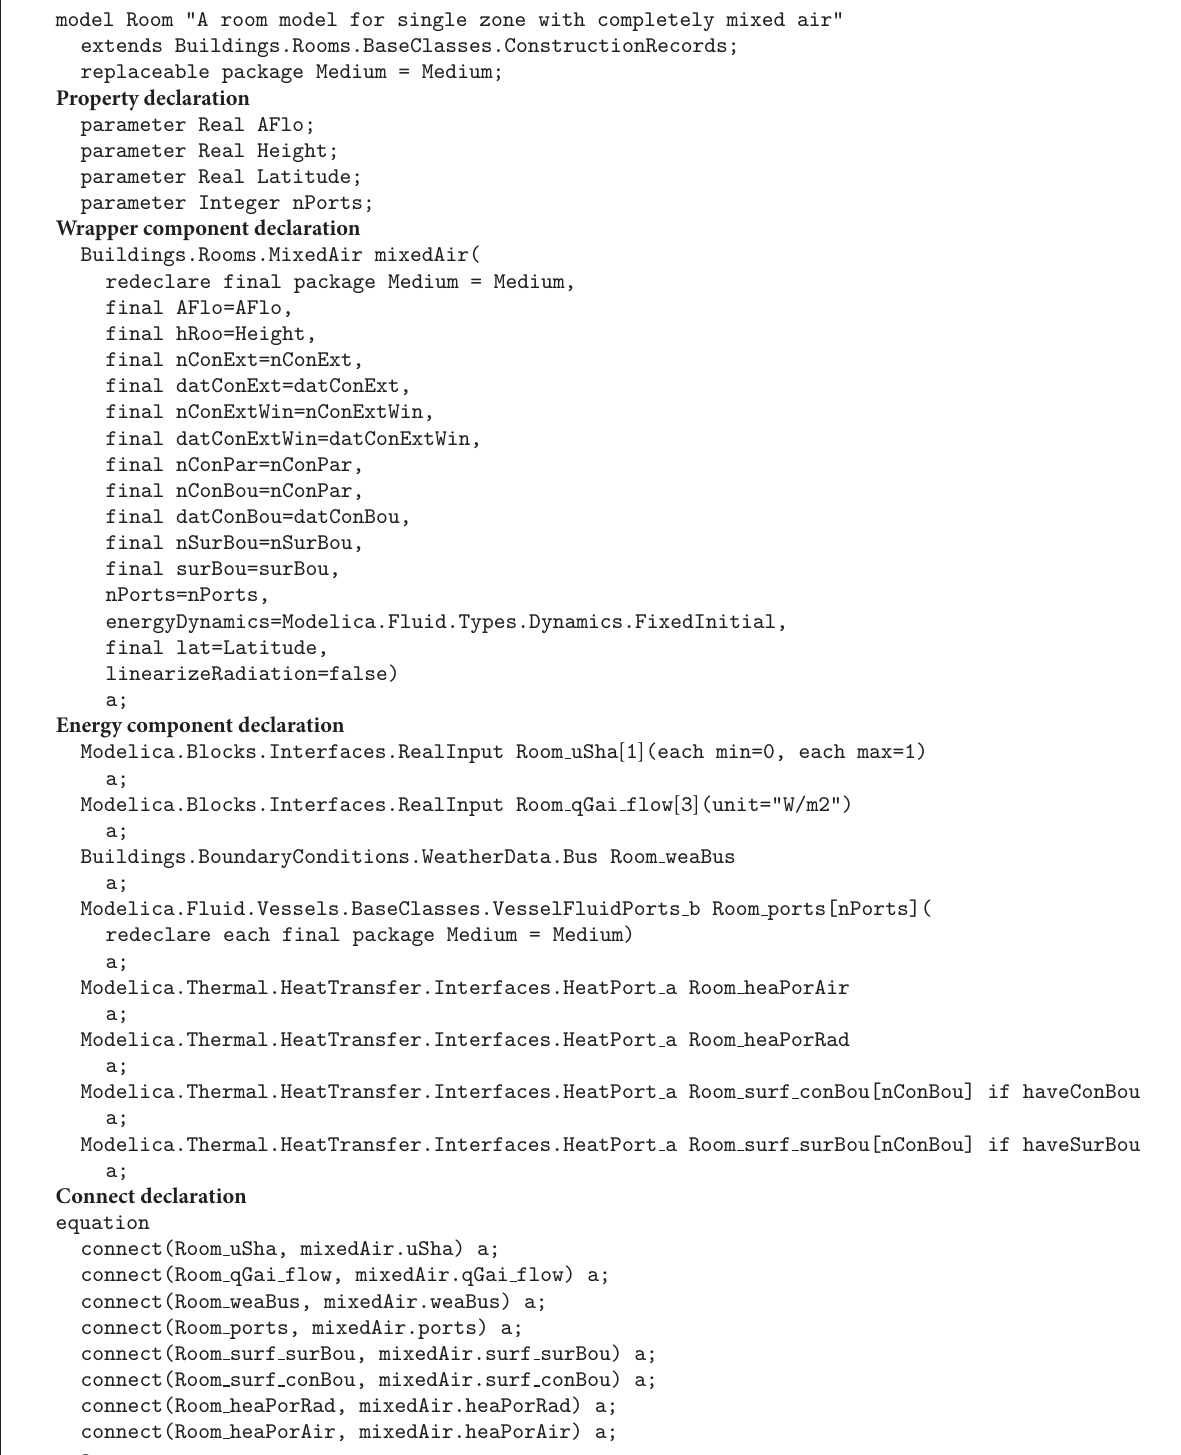
Algorithm 2: Implementation of the room class as a wrapper class based on Modelica language